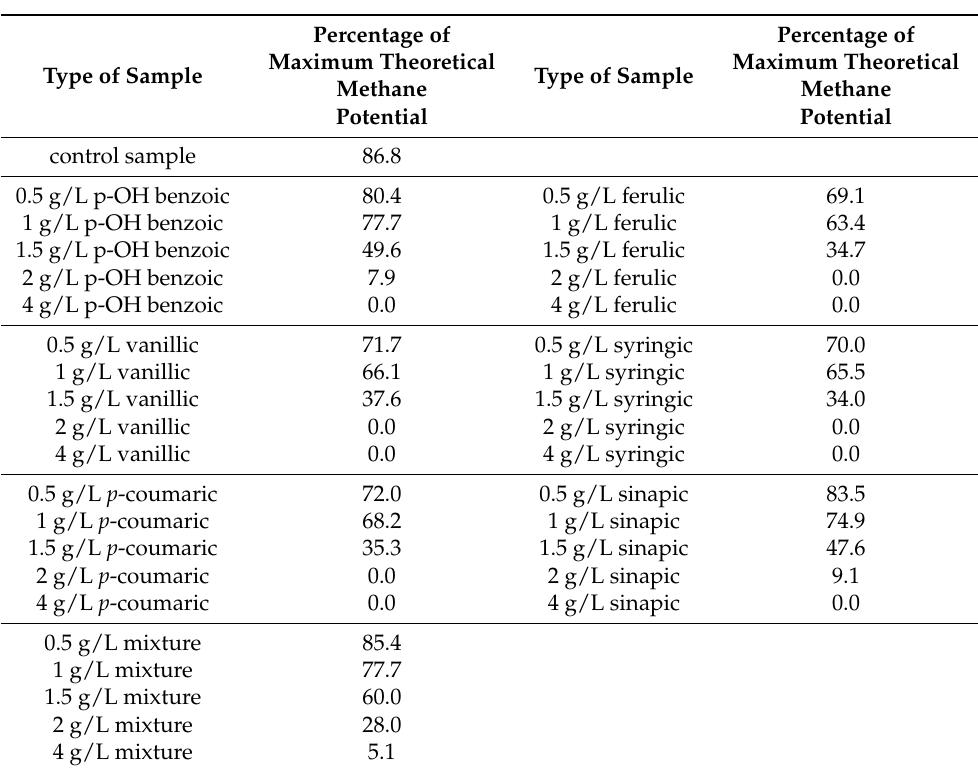
Table 2. Methane potential of distillery stillage spiked with phenolic acids as a percentage of the maximum theoretical methane potential. Percentage of Percentage of Maximum Theoretical Maximum Type of Sample Type of Sample Methane Potential